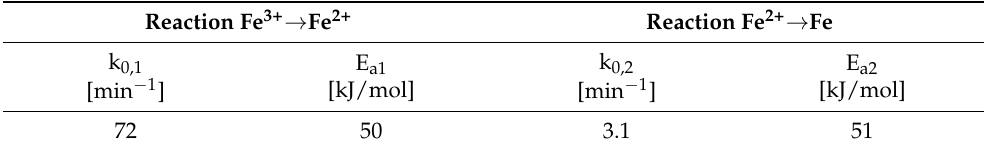
Table 5. Apparent rate constant pre-exponential factors and activation energies according to the non-isothermal model (Model